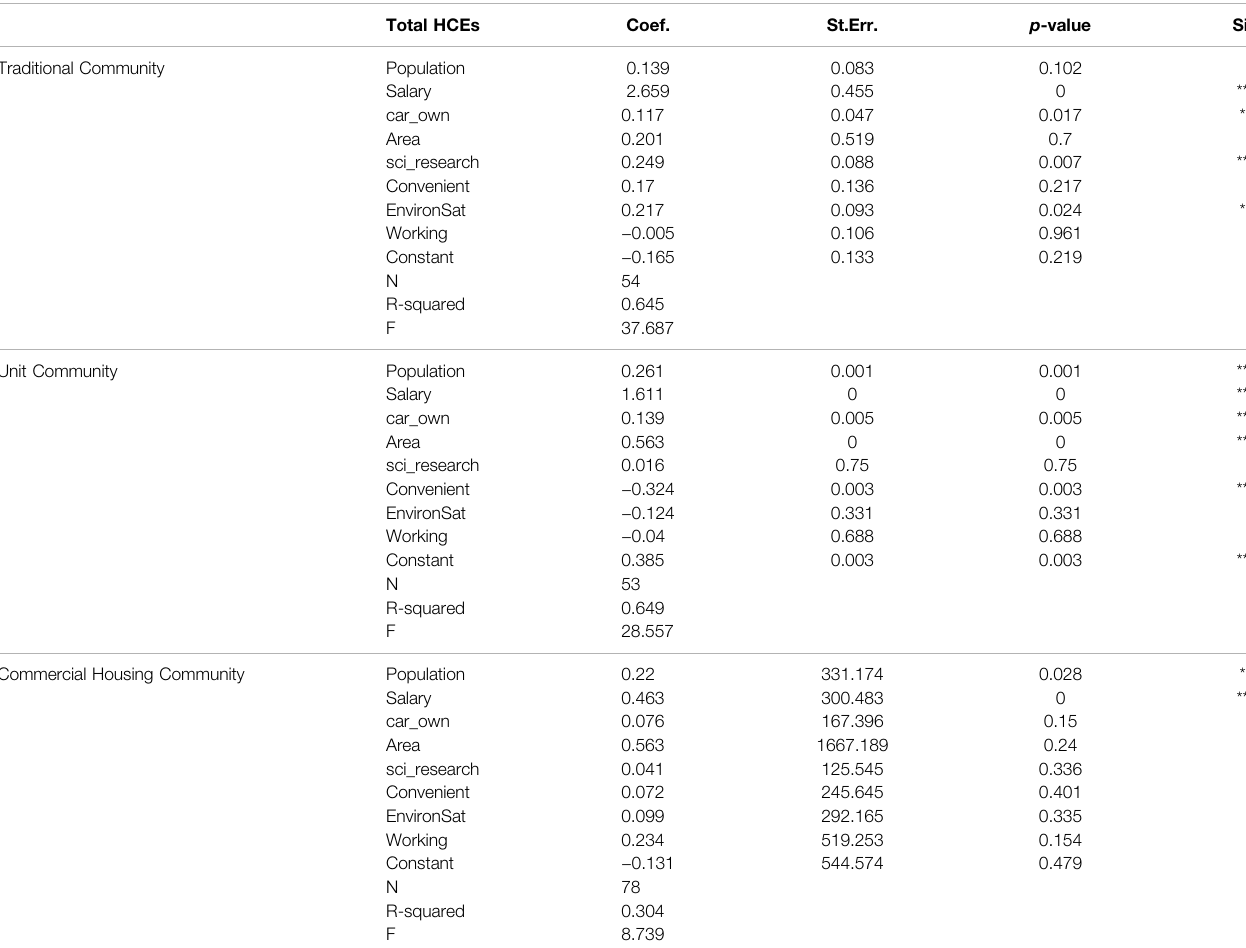
TABLE 7 | Regression analysis results of HCEs in three typical communities. Total HCEs